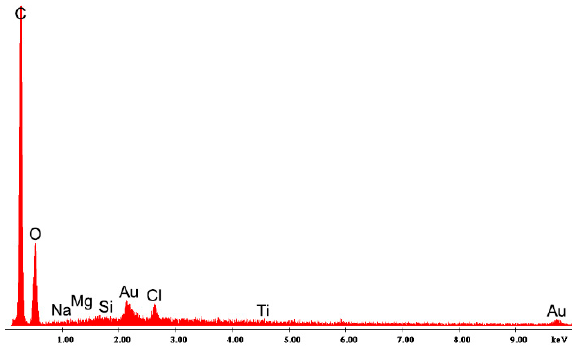
Figure 10. EDAX spectrum for globular formation on the surface of the MXE pellets.